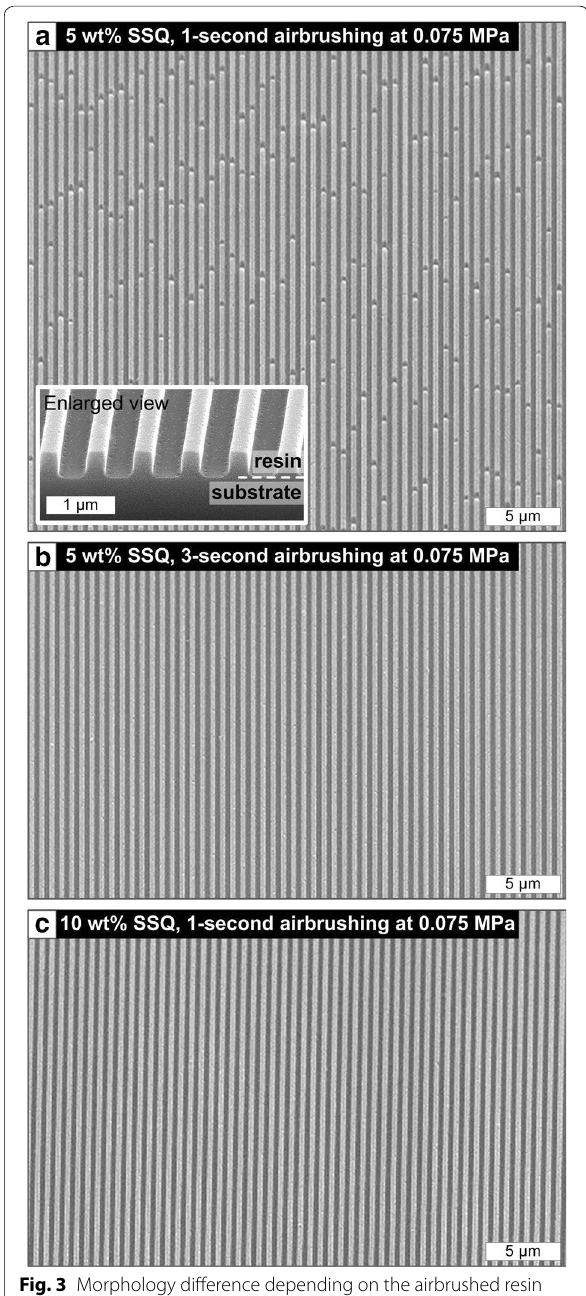
Fig. 3 Morphology difference depending on the airbrushed resin amount: line continuity. SEM images of R2R NIL-fabricated 700 nm- period nanograting patterns on the airbrushed SSQ resin films at lowered pressure of 0.075 MPa with different concentrations and airbrushing times of a 5 wt% and 1 s, b 5 wt% and 3 s, and c 10 wt% and 1 s, respectively. The discontinued lines are observed in a as the insufficient resin dewets on the substrate surface upon UV curing. The inset to a shows an enlarged SEM image of the cross-section indicating a near-zero RLT. The increased amount of resin either by increasing the airbrushing time ( b ) or resin concentration ( c ) results in continuous nanograting under the identical R2R NIL